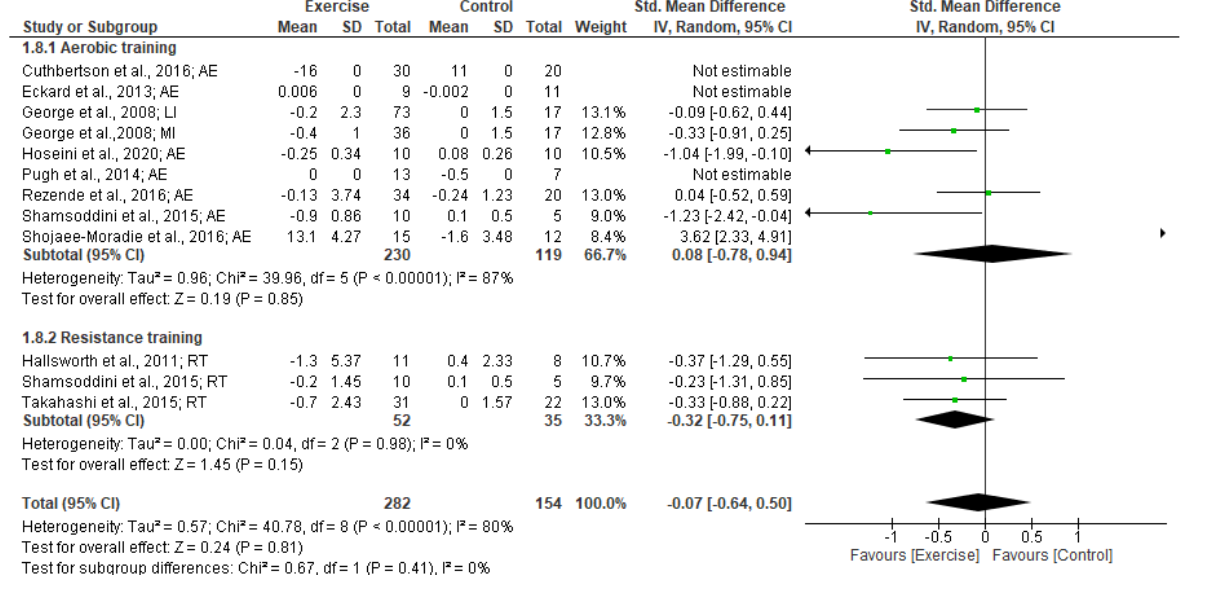
Figure 6. Forest plot showing study precision against the mean difference effect estimate with 95% confidence interval for HOMA-IR [30,31,36–38,40,42,43,49,51]. Subgroup analysis based on intervention duration indicated a significantly small effect on HOMA-IR for <12 weeks (SMD: − 0.46 [95% CI, − 0.74 to − 0.18], p = 0.001; I 2 = 0%, p